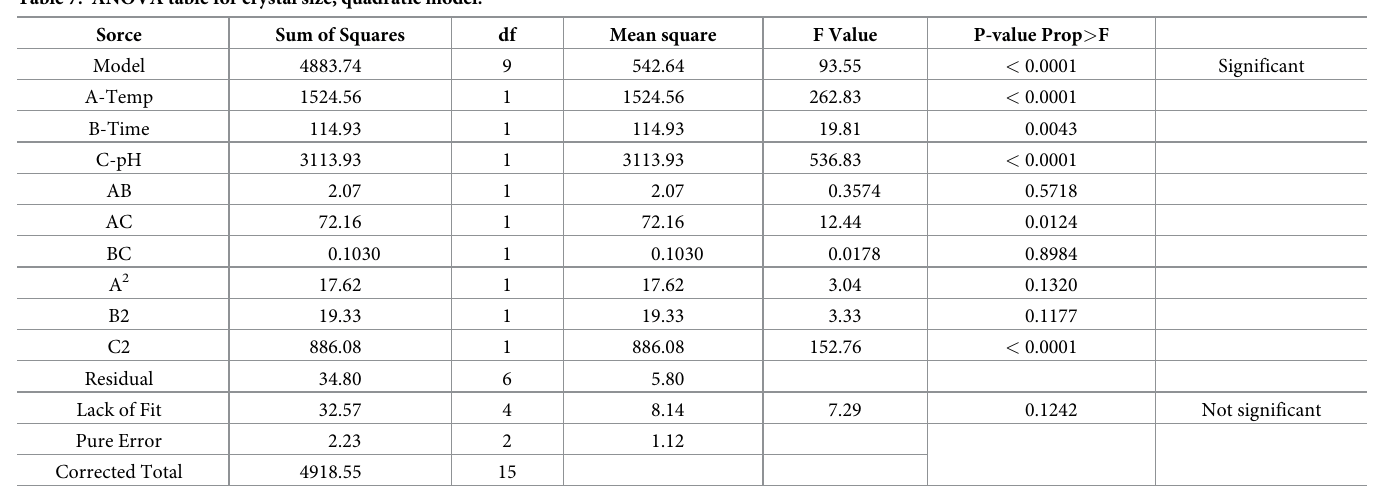
Table 7. ANOVA table for crystal size, quadratic model. Sorce Sum of